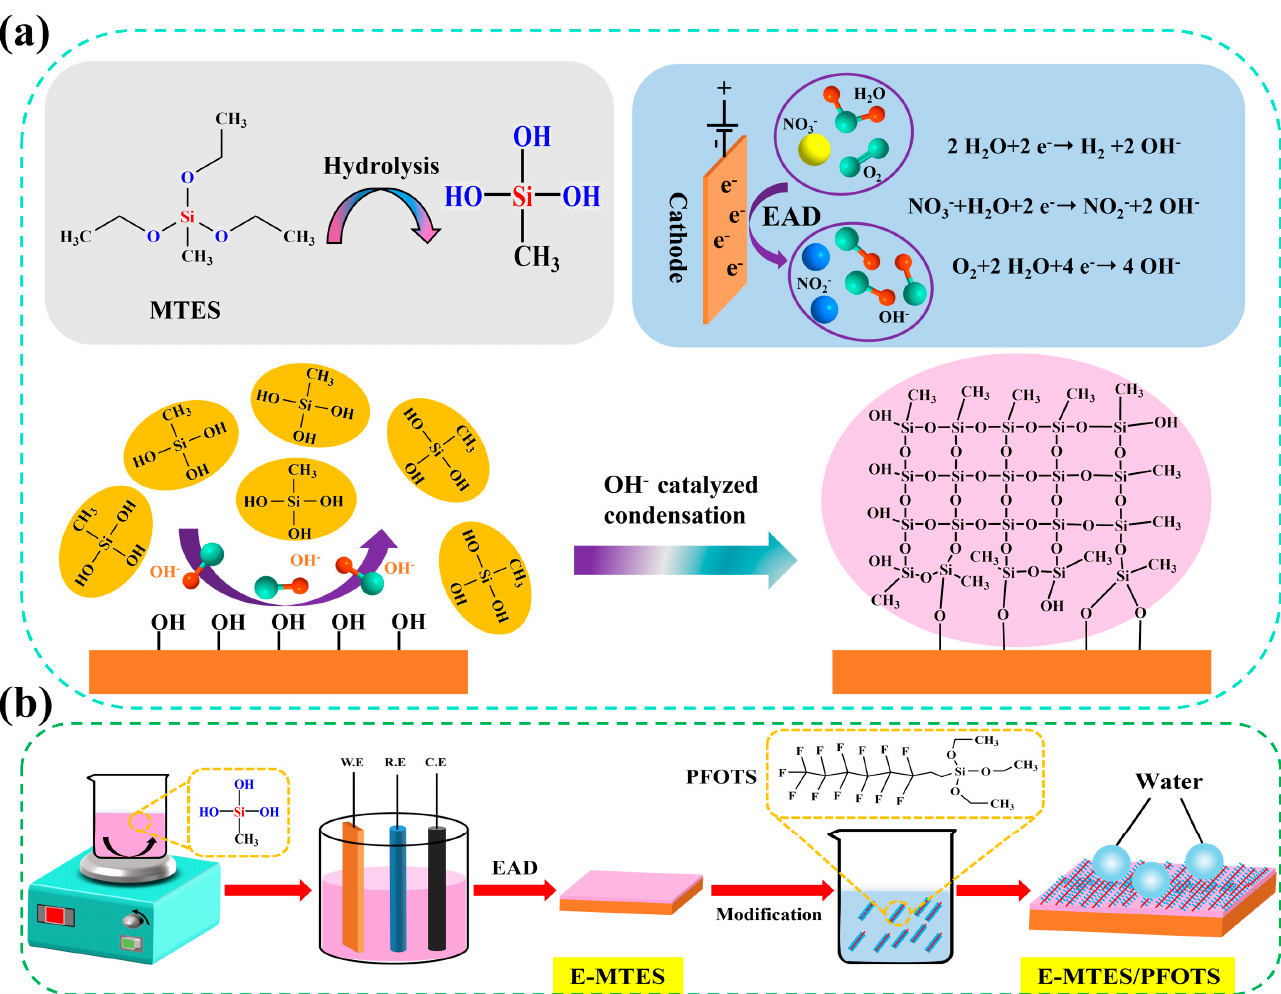
Figure 1. Schematic diagram of ( a ) hydrolysis reaction of MTES and EAD of catalytic condensation- reacted silica films on Cu substrates and ( b ) two-step EAD for the preparation of superhydrophobic E-MTES/PFOTS films.